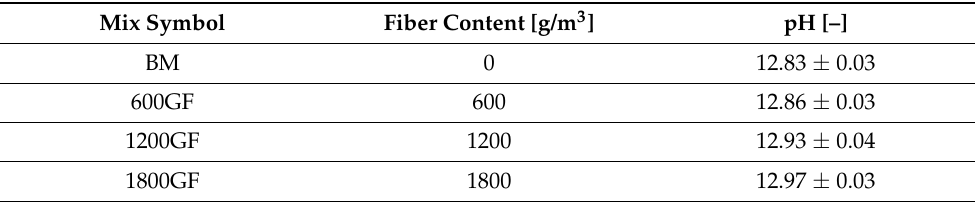
Table 6. The pH test